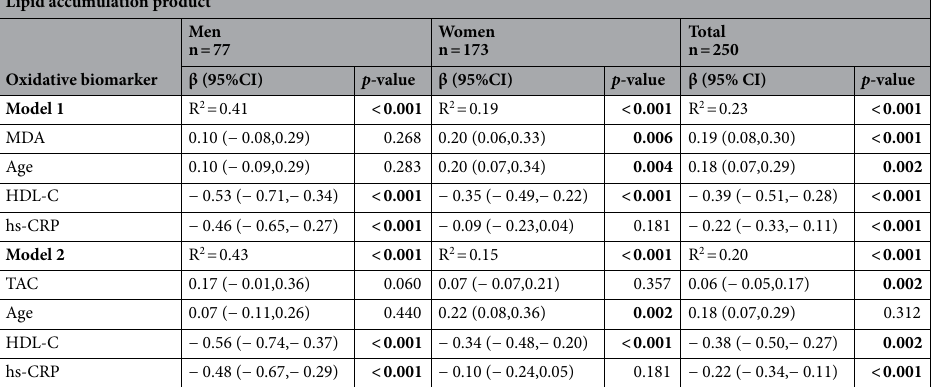
Table 3. Association between LAP and oxidative stress biomarkers (MDA and TAC) adjusted by confounders among men (n = 77) and women (n = 173). LAP: lipid product accumulation; MDA: malondialdehyde; HDL-C: high density lipoprotein-cholesterol ; hs -CRP: high-sensitive C-reactive protein; TAC: total antioxidant capacity. p-value less than 0.05 was considered statistically significant.